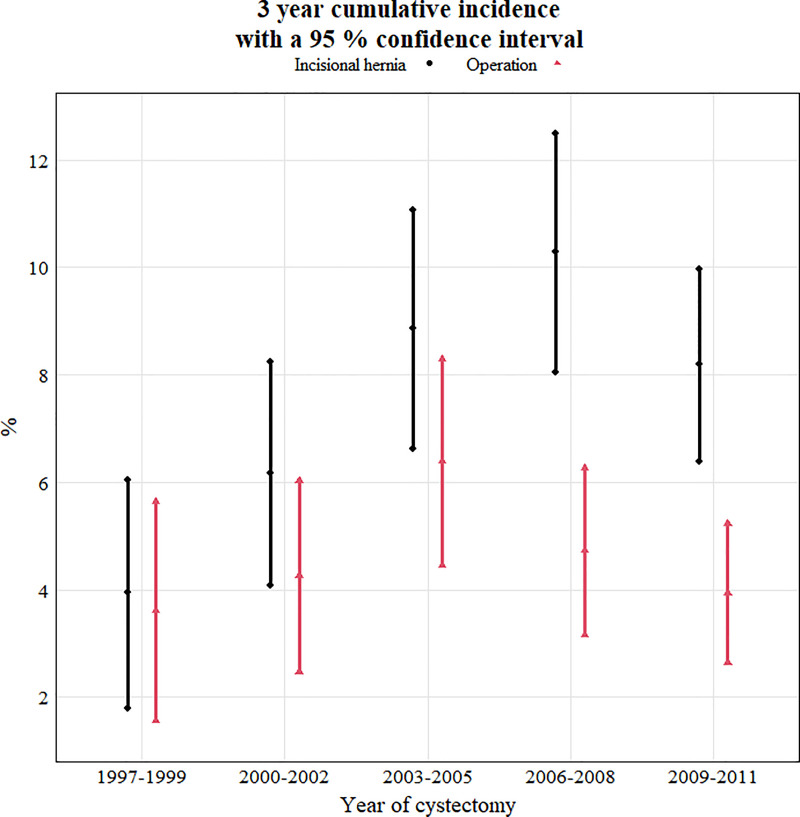
Three year cumulative incidence with a 95% confidence interval.Three year cumulative incidence midline incisional hernia diagnosis with 95% confidence intervals (black bars) and midline incisional hernia surgery (red bars), stratified by three-year time-periods. Patients with cystectomy during the last three-year strata 2012–2014 were excluded, as they did not have three years follow-up time.